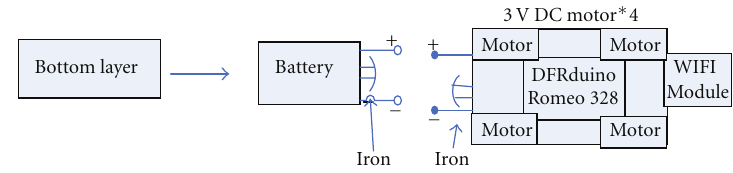
Figure 7: The sketch of bottom layer.